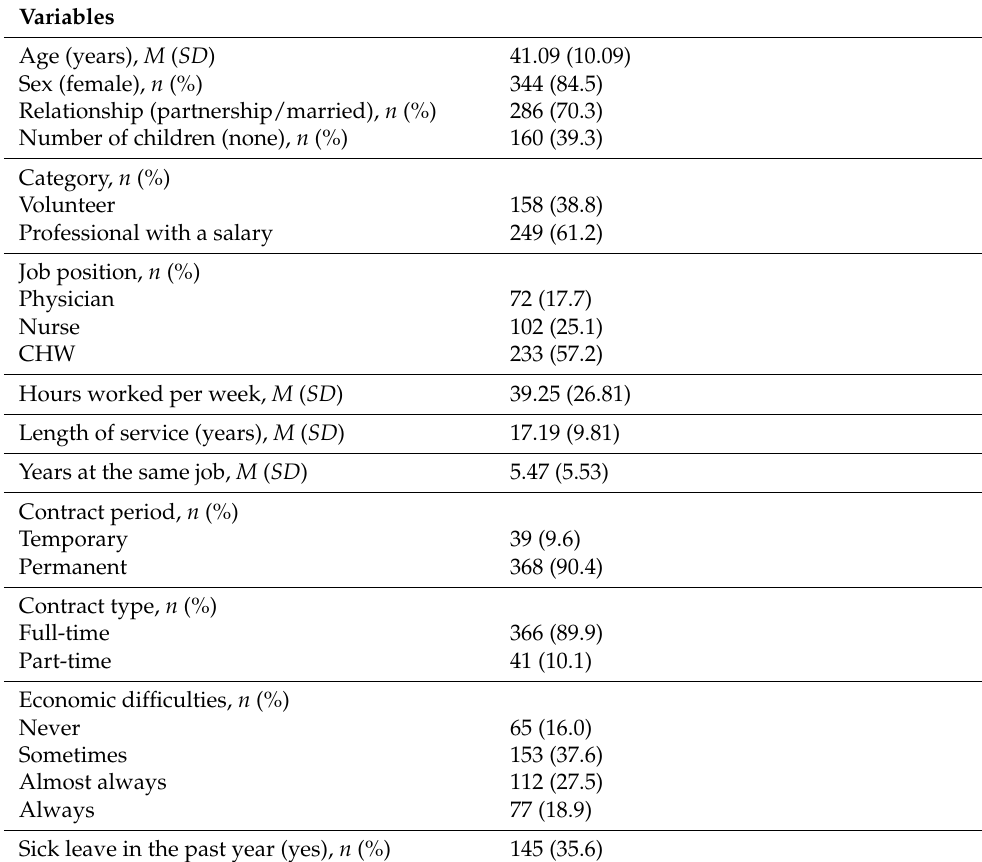
Table 1. Sociodemographic characteristics of study